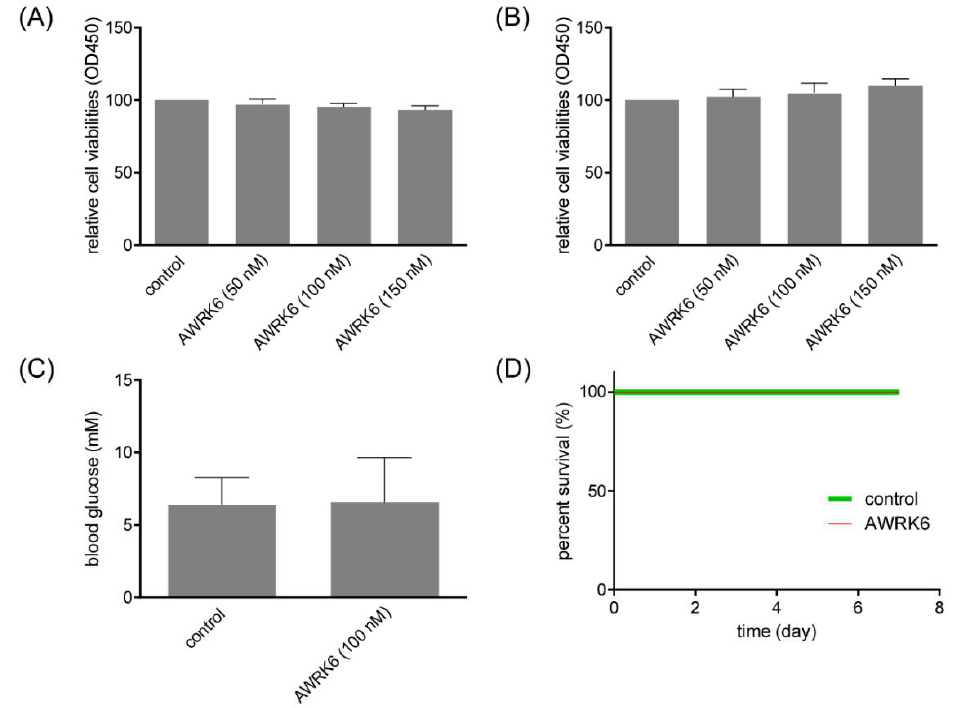
Figure 6. AWRK6 showed no toxicity in vivo and in vitro. ( A ) The cell viability of Min6 cells treated with AWRK6, analyzed by CCK-8 assay. ( B ) The lactate dehydrogenase (LDH) release of Min6 cells treated with AWRK6, analyzed by LDH assay. ( C ) The blood glucose in normal mice treated with AWRK6, analyzed using a glucometer. ( D ) The survival curve of diabetic mice treated with a high dose of AWRK6. The error bar indicates standard deviation.